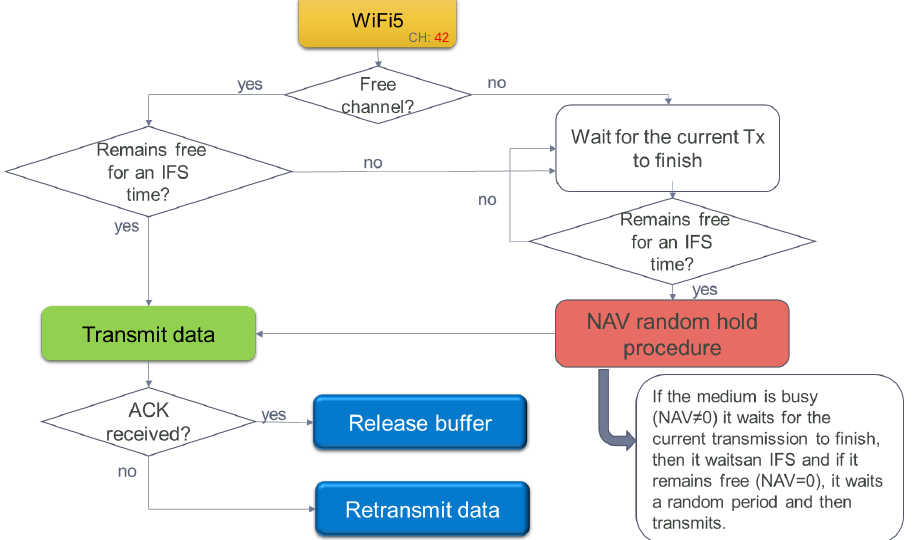
Figure 13. Distributed Coordination function in WLAN transmission